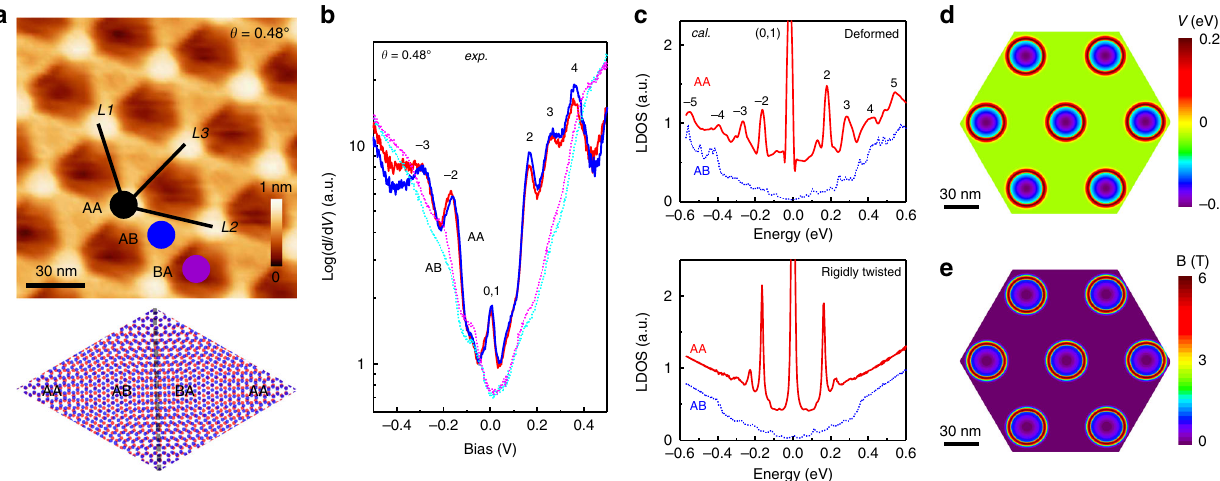
Fig. 1 Electronic properties of TBG with twist angle θ ¼ 0 : 48 (cid:1) . a STM topography image (100 nm ´ 100 nm ) with hexagonal moiré pattern (top panel) and the atomic model of AA, AB, and BA stacking regions (bottom panel). The three moiré wavelengths are: L 1 (cid:3) L 2 (cid:3) L 3 (cid:3) 29 : 6 nm . Sample bias V ¼ 100 mV , tunneling current I ¼ 1 : 0 nA . b Logarithmic dI/dV spectra measured at AA and AB regions. The two solid (dashed) lines were taken at t different AA (AB) regions to show reproducibility (curves are vertically shifted for clarity). c Calculated local density of states in the AA and AB regions for deformed (upper panel) and rigidly twisted (bottom panel) cases. d , e Calculated local potential V and pseudo-magnetic fi elds B ,